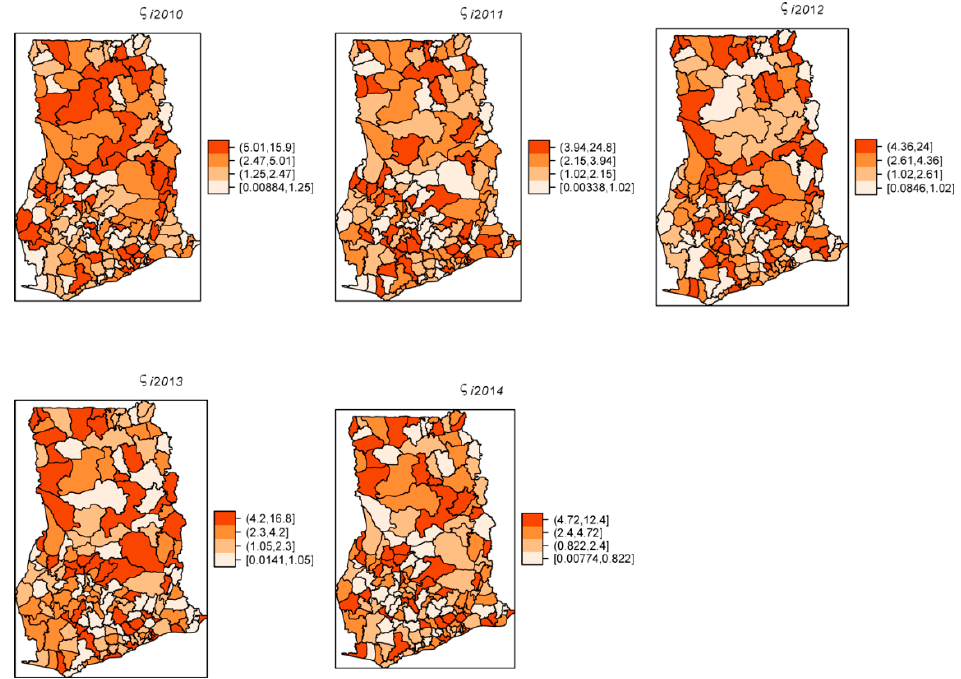
Figure 3. Yearly posterior risk estimates per 100 people of intestinal parasites infection, 2011–2014.